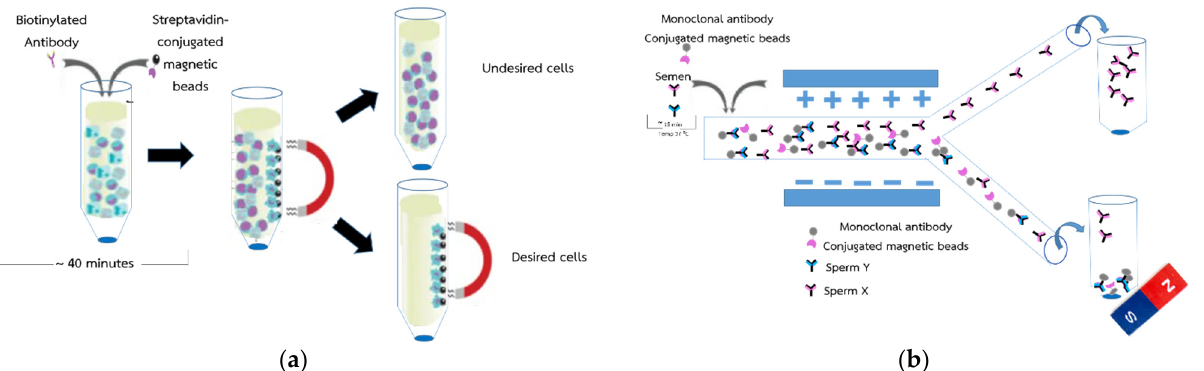
Figure 1. The conceptual of the sorting of sperm X and Y ( a ) shown the method for separation efficiency of protein by magnetic beads and ( b ) shown the method for separation efficiency of sperm by magnetic beads.